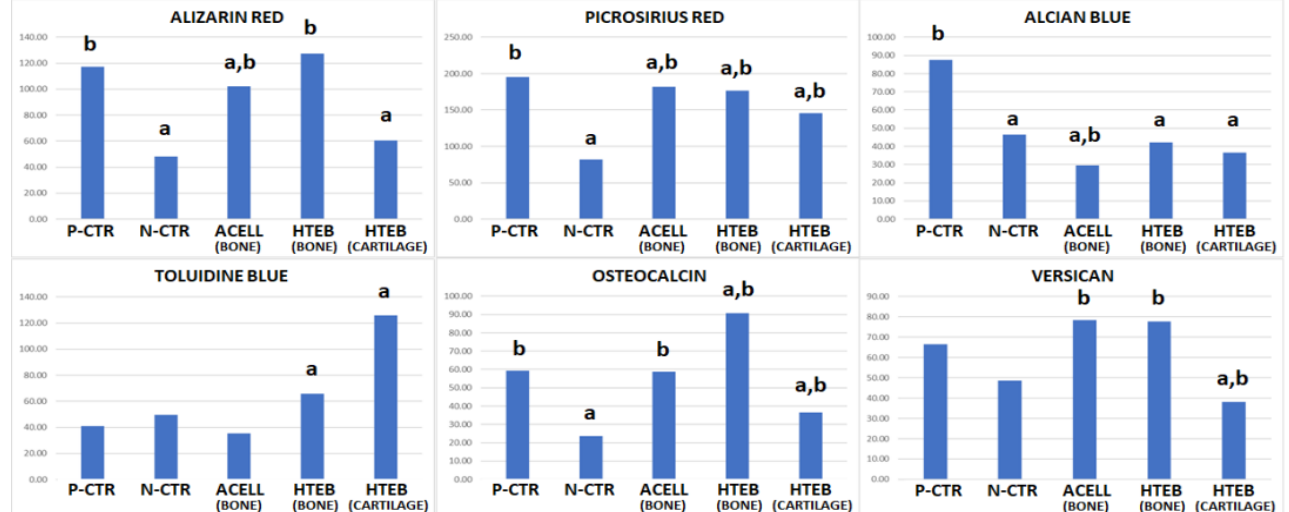
Figure 7. Quantitative analysis of ECM components as determined by histochemistry (alizarin red, picrosirius red, alcian blue, and toluidine blue) and immunohistochemistry (osteocalcin and versican). Results correspond to average values in each study group. P-CTR: native normal animals, used as positive controls; N-CTR: animals subjected to surgical removal of a fragment of the right mandible, used as negative controls; ACELL: animals subjected to surgical removal of a fragment of the right mandible and implant of a nanostructured fibrin–agarose biomaterial; HTEB: animals subjected to surgical removal of a fragment of the right mandible and implant of a nanostructured human tissue-engineered bone substitute. a: differences with P-CTR are statistically significant; b: differences with N-CTR are statistically significant.